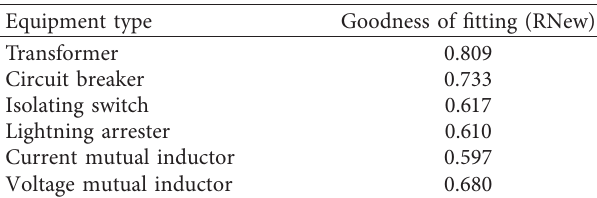
Table 3: The fitting goodness of the relationship curve between the damage rate of high-voltage electrical equipment and the instru- mental seismic